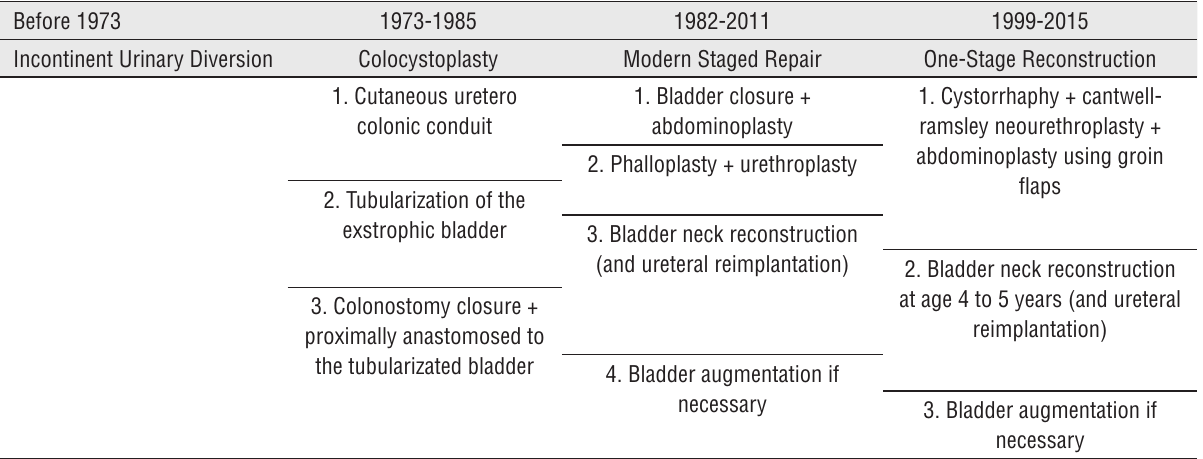
Table 1 - Treatment of bladder exstrophy in male patients (time table). Before